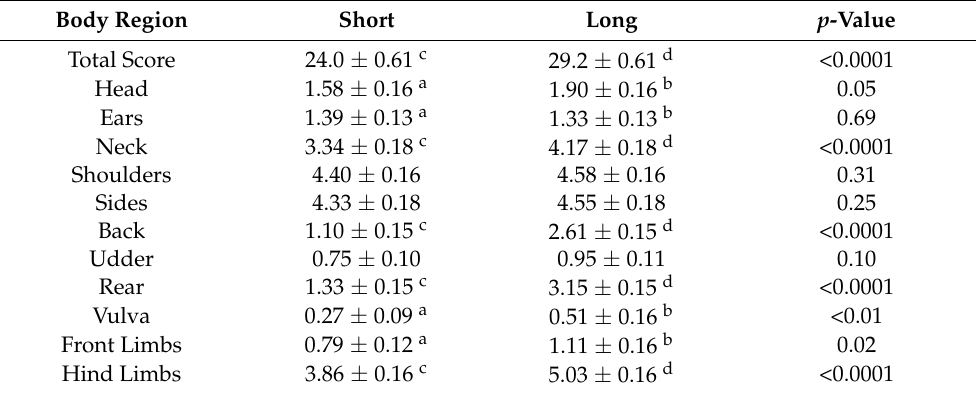
Table 5. The main effect of length of partition on mean skin lesion scores 1